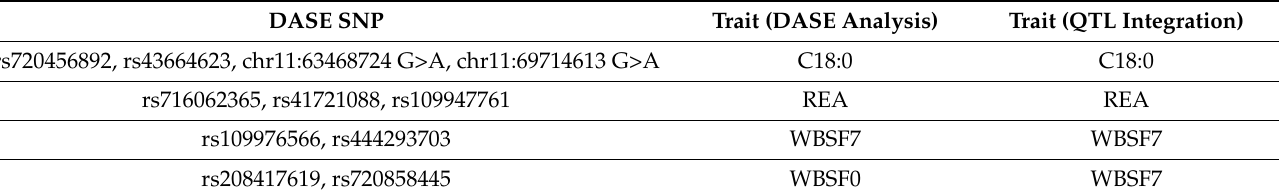
Table 1. DASE SNPs overlapping QTLs associated with the same phenotypes in both analyses. DASE SNP Trait (DASE Analysis) Trait (QTL Integration) rs720456892, rs43664623, chr11:63468724 G>A, chr11:69714613 G>A C18:0 C18:0 REA REA WBSF7